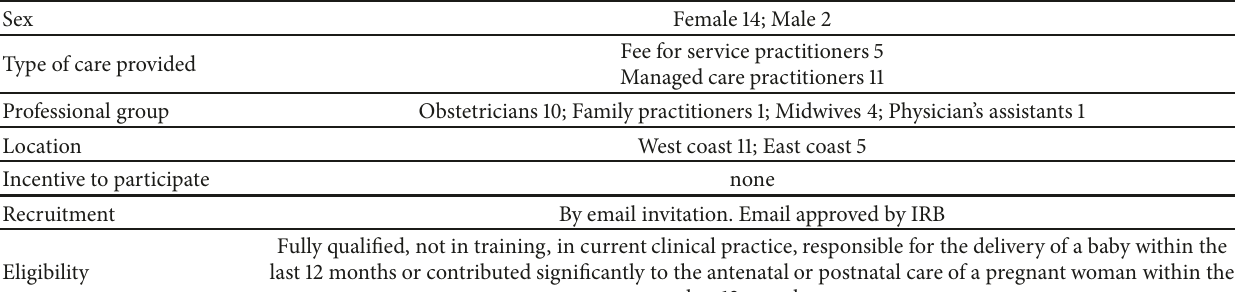
Table 1: Participants’ demographics and other relevant